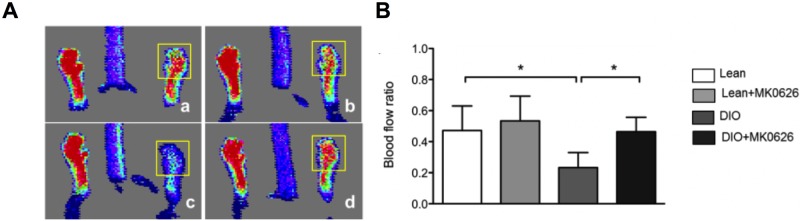
Blood flow recovery rate after HLI.(A) Laser Doppler imaging was used to analyze blood flow 14 days after ischemia. The panels show lean mice (Aa), MK-0626-administered lean mice (Ab), DIO mice (Ac), and MK-0626-administered DIO mice (Ad). The region of interest (ROI) for blood flow measurement is shown by the yellow square. (B) The graph presents blood flow ratio of ischemic-to-contralateral hind limb, during the observation period at day 14. Experiments were repeated twice. In the graph, *P < 0.05, **P < 0.01, and ***P < 0.001, determined by Kruskal-Wallis and followed Dun’s multiple comparison test.